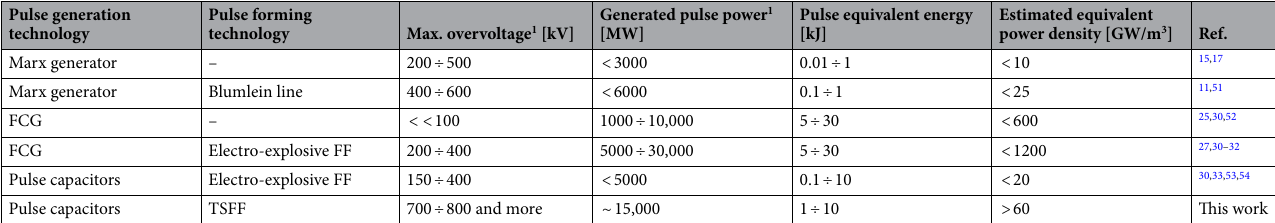
Table 2. Maximum achievable parameters of high power pulse generation and forming systems—comparison of the compact technologies and state of the art. 1 Defined as the absolute maximum values of the generated pulse at the optimal load (Marx generators) or without load (in the case of FF